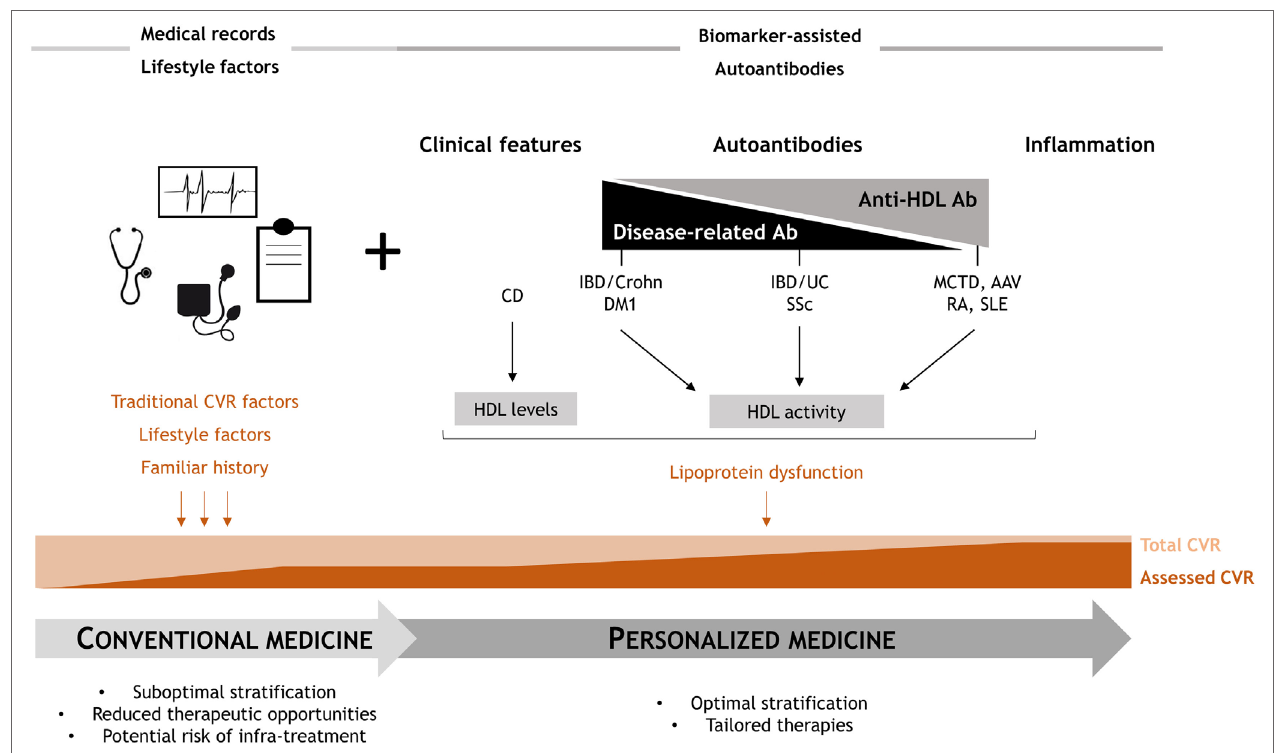
FigUre 4 | Overview of the study findings: clinical relevance. Conventional clinical CVR management provides a suboptimal risk stratification, since only a partial estimation of the actual risk is achieved. Anti-high-density lipoprotein (HDL) antibodies may cover this unmet clinical need, as they are able to account, at least in part, for the lipoprotein dysfunction. Depending on the role of anti-HDL and disease-related autoantibodies, four different scenarios can be proposed, hence providing a rationale for personalized medicine approaches to improve the current standards of care in these